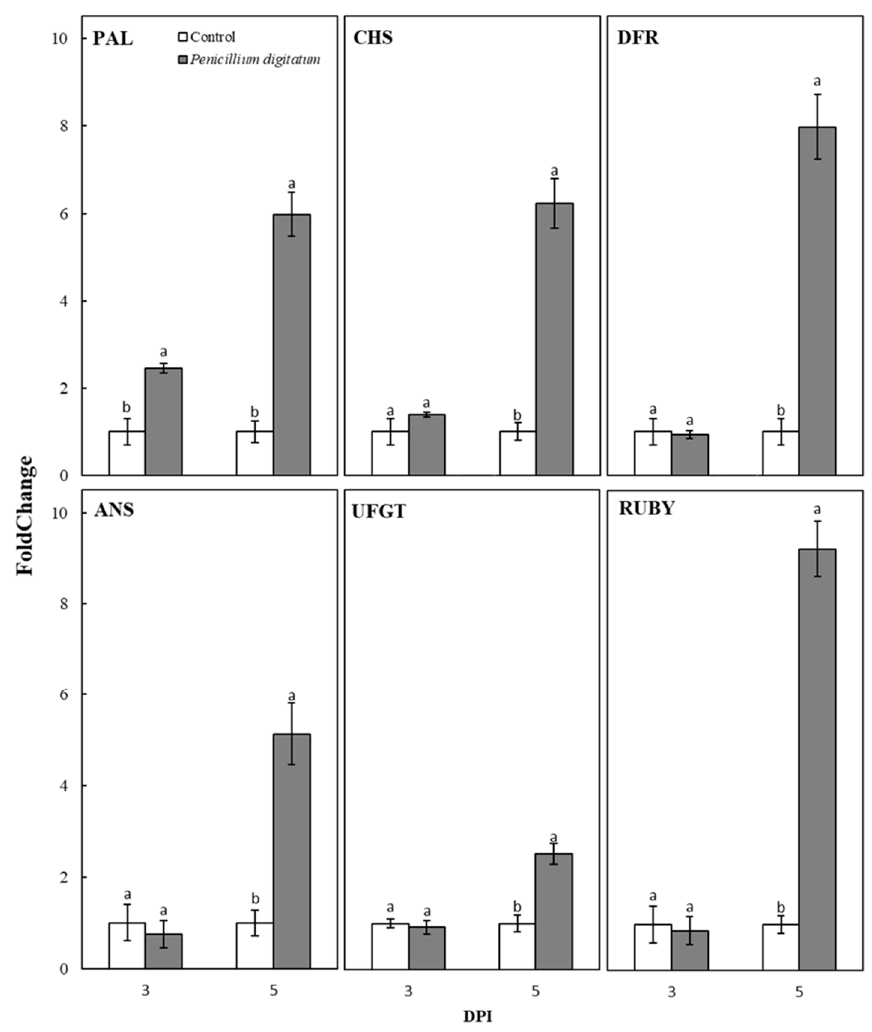
Figure 3. Evaluation of gene expression in control and inoculated fruits PAL, CHS, DFR, ANS, UFGT, and RUBY. Each point represents the mean value of three replications ± SD. Significantly different values, within each sampling time, are indicated by different letters ( p < 0.05).